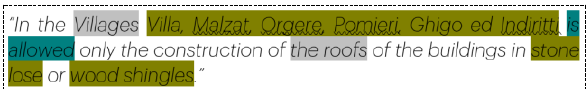
Figure 10. Concepts, relations and properties from the Building Regulation of Prali.